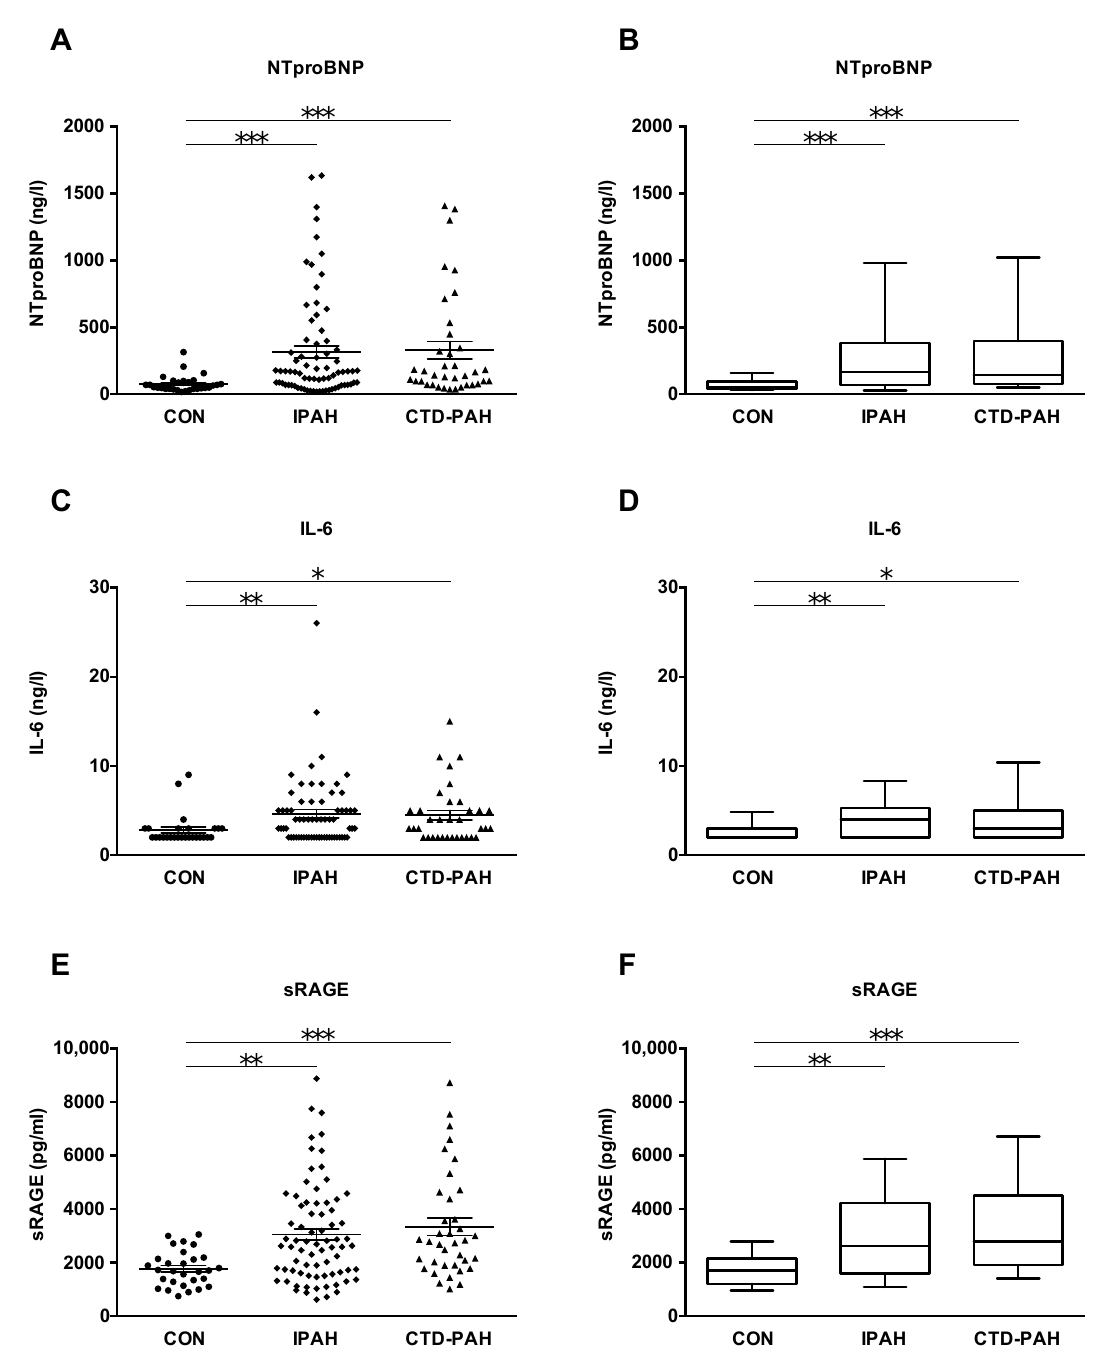
Figure 1. NTproBNP, IL-6 and sRAGE plasma concentrations are elevated in patients with pulmonary arterial hypertension versus controls. ( A , B ) NTproBNP plasma concentrations of patients with idiopathic pulmonary arterial hypertension (IPAH, n = 74) and connective tissue disease-associated pulmonary arterial hypertension (CTD-PAH, n = 37) versus controls (CON, n = 29). ( C , D ) IL-6 plasma concentrations of IPAH (n = 66) and CTD-PAH (n = 35) patients versus controls (n = 27). ( E , F ) sRAGE plasma concentrations of IPAH (n = 74) and CTD-PAH (n = 37) patients versus controls (n = 29). The scatter plots on the left show the mean ± SEM, the box and whisker plots on the right show the median with interquartile range ± 10–90 percentile. Statistical test: Kruskal–Wallis test, corrected for multiple testing by Dunn’s test. * p < 0.05, ** p < 0.01, *** p < 0.001. Abbreviations: IL-6, Interleukin-6; NTproBNP, N-terminal pro-brain natriuretic peptide; sRAGE, soluble receptor for advanced glycation end products.